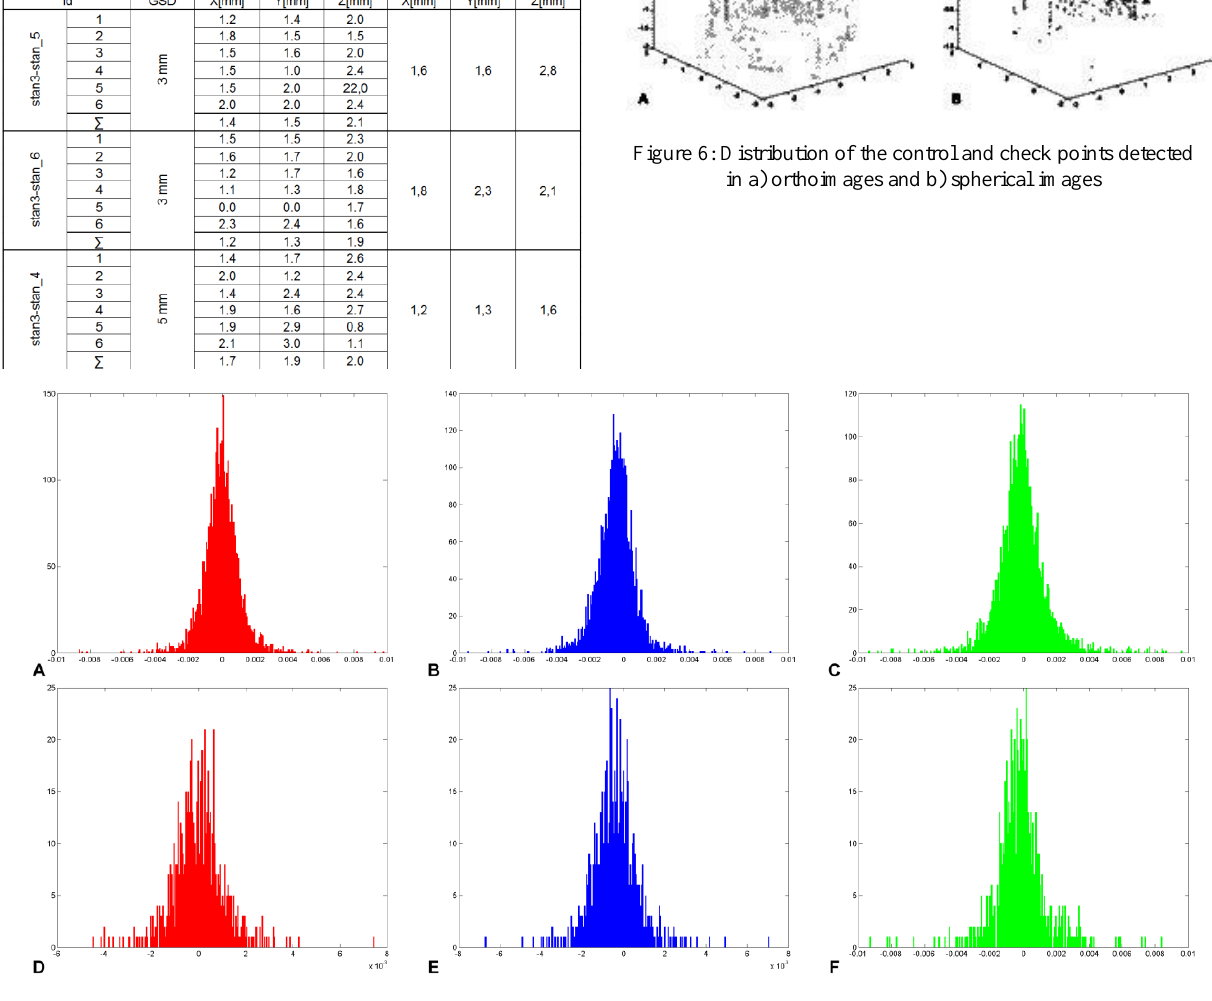
Figure 5: Histograms of the deviations of the control and check points for orthoimages: (a) X direction in pixels - control; (b) Y direction in pixels - control; (c) Z direction in pixels - control; (d) X direction in pixels – check; (e) Y direction in pixels – check; (f) Z direction in pixels –